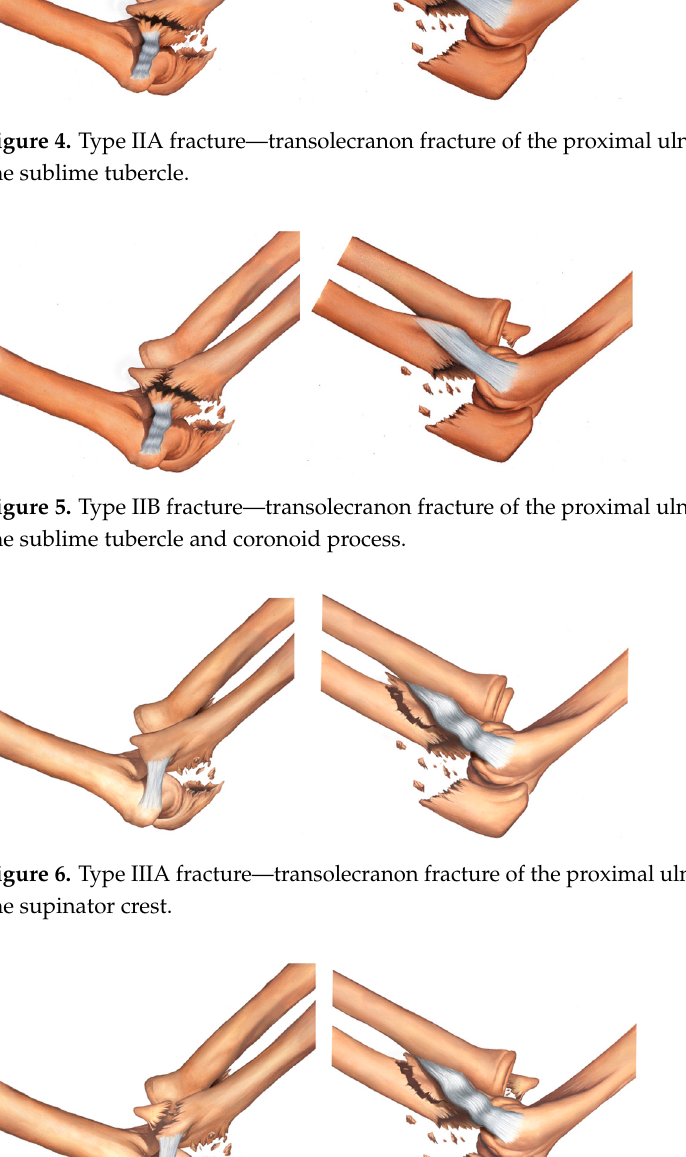
Figure 7. Type IIIB fracture—transolecranon fracture of the proximal ulna with associated fracture of the supinator crest and coronoid process.